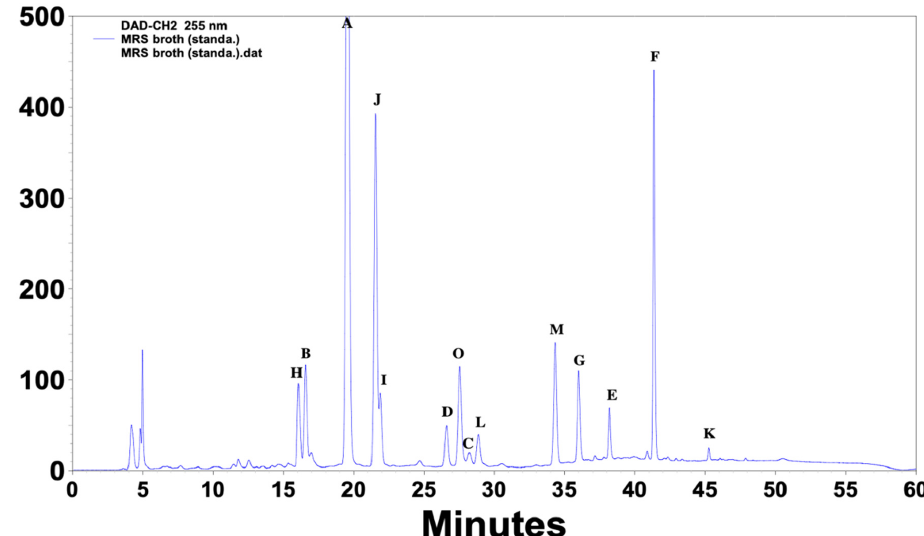
Figure 1. Chromatogram at 255 nm of 14 standard mixes (50 ppm; 10 mL injection) of previously reported antifungal compounds from LAB prepared in water–methanol (90/10) and MRS broth